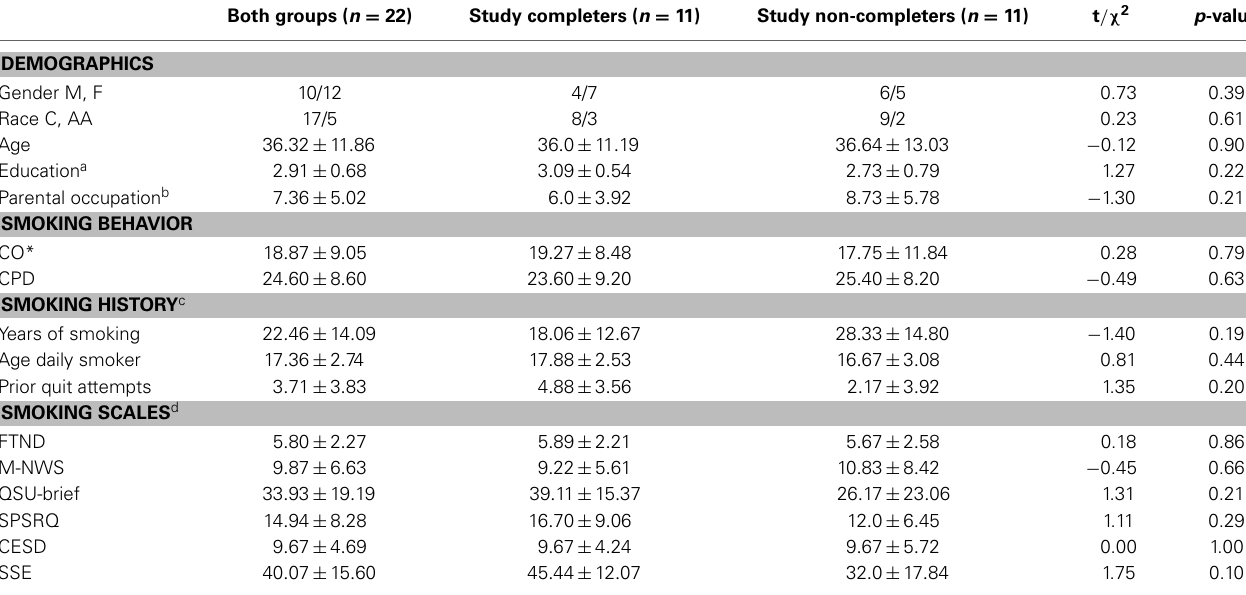
Table 5 | Baseline Characteristics of Study